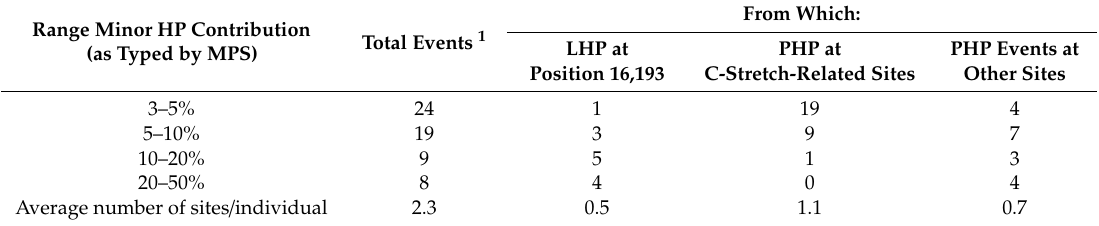
Table 1. Observed number of HP events in 26 buccal references categorised by HP level. Range Minor HP Contribution (as Typed by